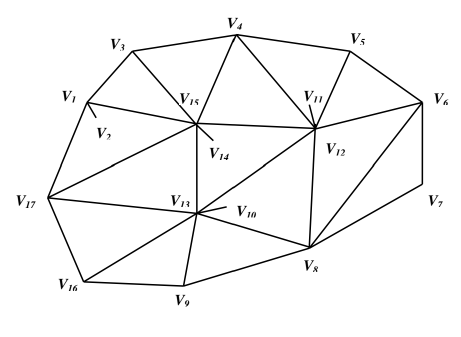
Figure 2. Example of Graph G(V,E) used as map shop, etc. This location cannot be used as a hop to reach